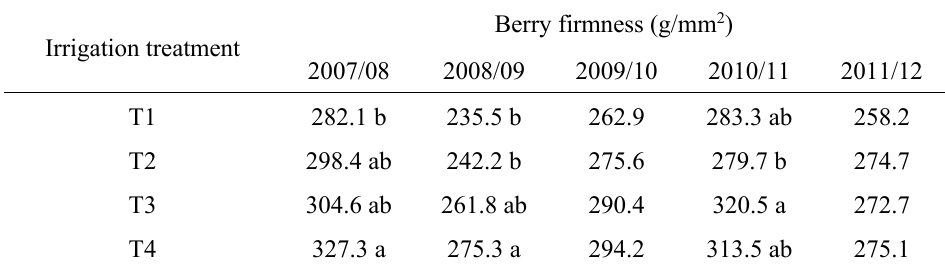
275.1 Means followed by a different letter within a given year are significantly different at P < 0.05. Table 7. Berry sugar content at harvest (ºBrix), in each treatment, in five experimental seasons. Sugar content (°Brix) Irrigation treatment 2007/08